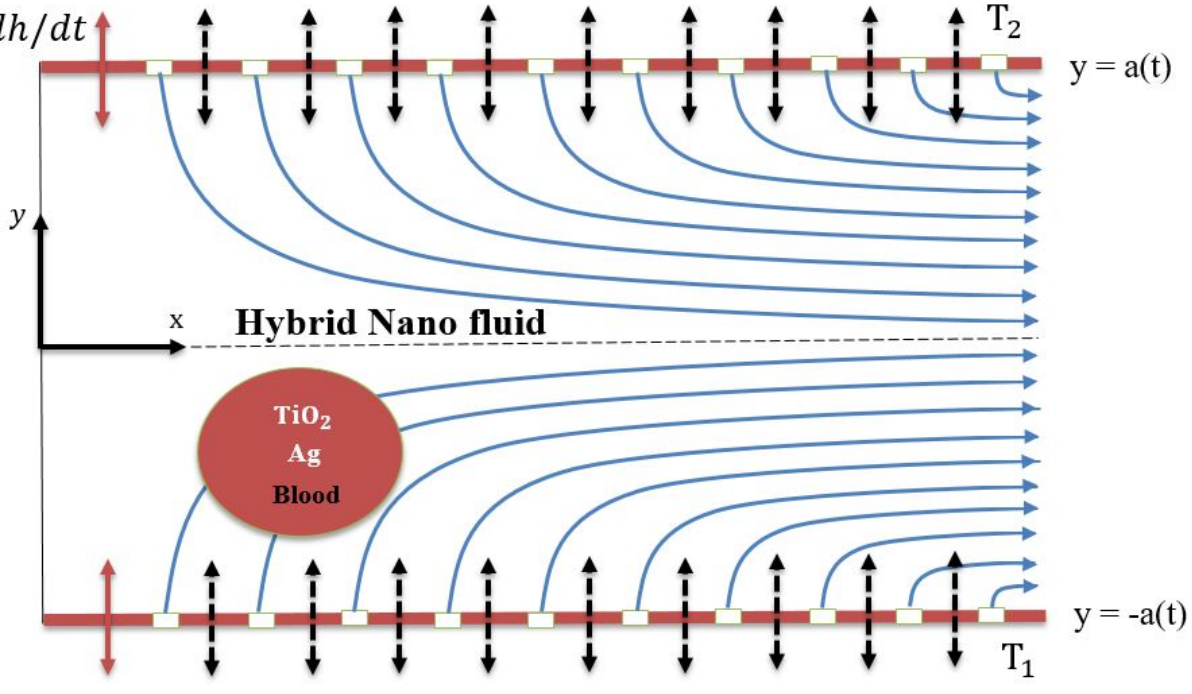
Figure 2. The schematic diagram of the problem.